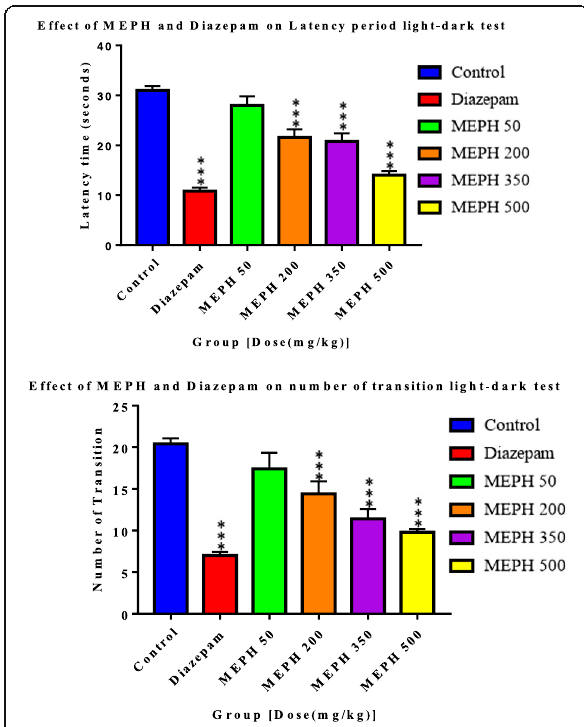
Fig. 6 The effect of MEPH on light-dark box test (Latency time; Transition; Time spent in light part; Time spent in dark part) in mice